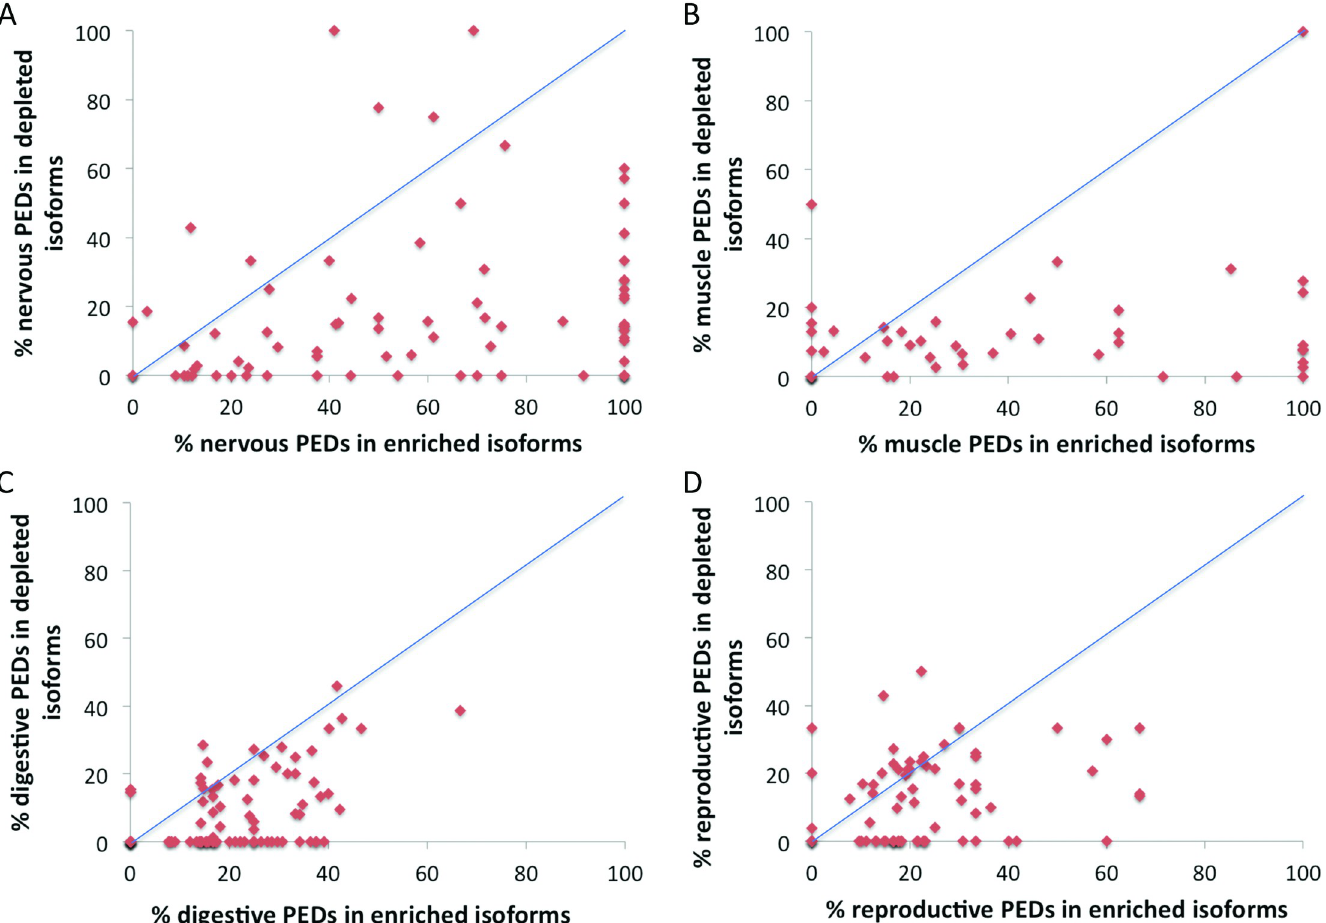
Fig 6. Scatter plot of the percentages of PEDs supporting transcript level enrichment. The figure shows scatter plots of the percentage of PEDs that support the selected tissue for the side of the event that is enriched in that tissue group in the transcriptomics experiments (X-axis) versus the percentage of PEDs that support the selected tissue for the side of the event depleted in the transcriptomics experiments (Y-axis). The diagonal line shows where the percentage of PEDs that support the side of the event that is enriched in the transcriptomics experiments is identical to the percentage of PEDs that support the side of the event that is depleted in that tissue group in the transcriptomics experiments. Events that have proportionally more PEDs on the transcript-enriched side of the event (those that agree with the transcriptomics evidence) ought to be below the line. Tissues shown are A. Nervous B. Muscle C. Digestive and D. Reproductive.